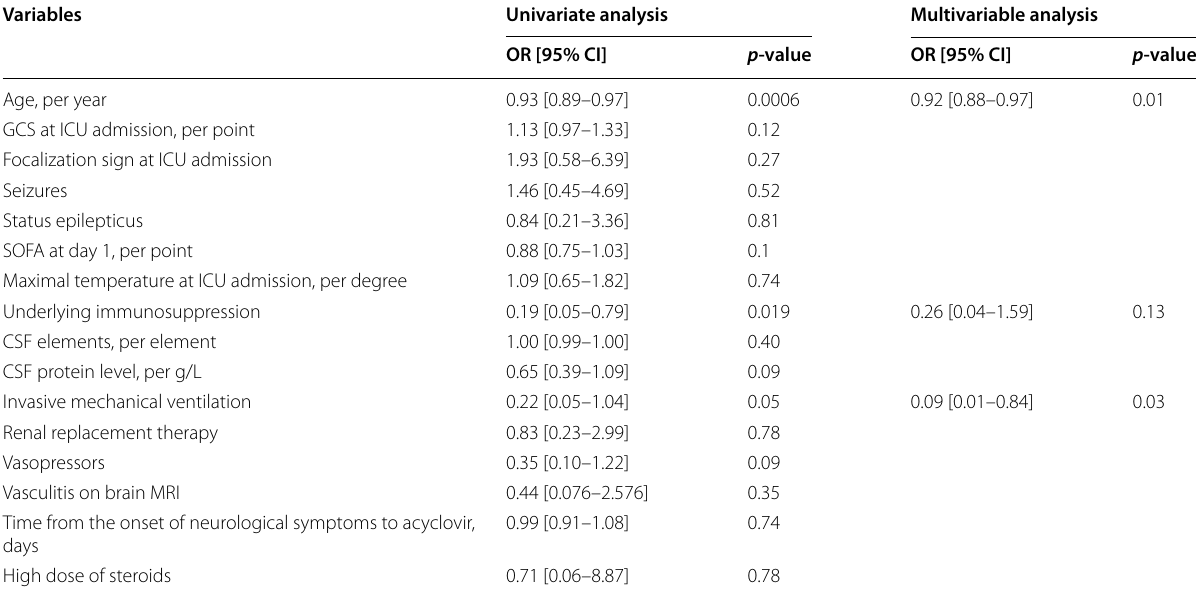
CSF, cerebrospinal fluid; GCS, Glasgow Coma Scale; ICU, intensive care unit; MRI, magnetic resonance imaging; SOFA, Sequential Organ Failure Assessment